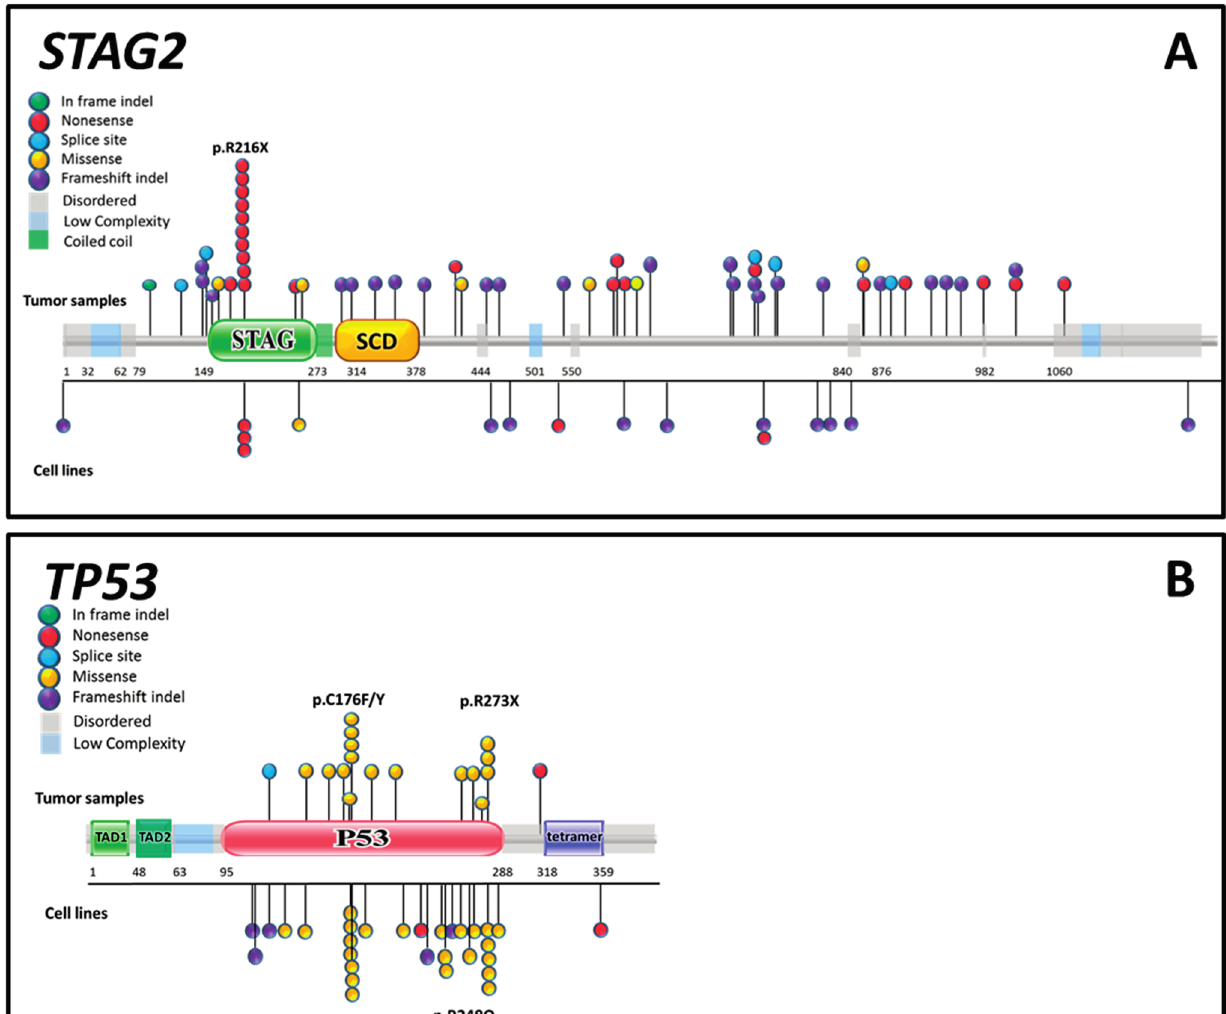
Figure 1. Mutation overview of reported STAG2 and TP53 in Ewing sarcoma. Overview of published mutations on STAG2 and TP53 from next generation sequencing data divided in five mutation subtypes based on data collected from 472 tumors and 54 cell lines. ( A ) Overview of the STAG2 mutations ( B ) Overview of the TP53 mutations. Amino acid sequence of the proteins is presented with different protein domains annotated in boxes and every sphere represents a reported